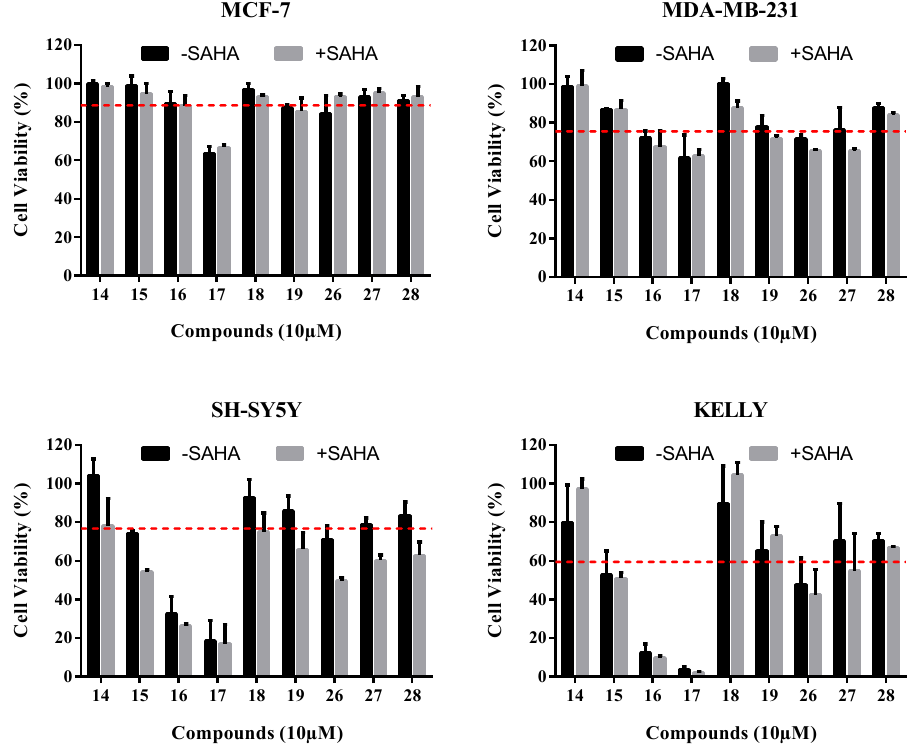
Figure 5. Cell viability of cancer cell lines after treatment at 10 μ M for 72 h, given as a percentage of the negative control (DMSO). Red line represents the cell viability of cell lines after treatment with 1 µM SAHA (0.5 µM SAHA for KELLY cells). Data represents the mean values (±S.D.) for three independent determinations.